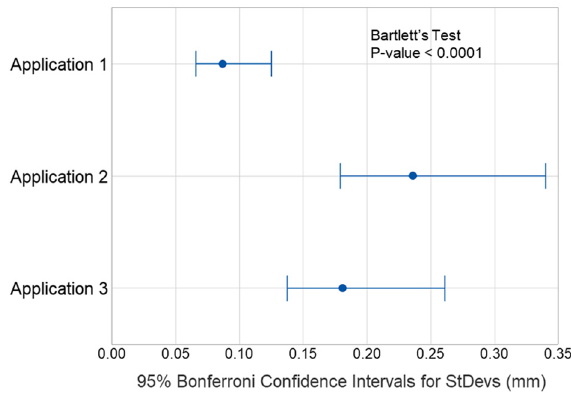
Figure 7. Testing the homogeneity of variance in the thickness measurement error data of Applica- tions 1, 2, and 3.